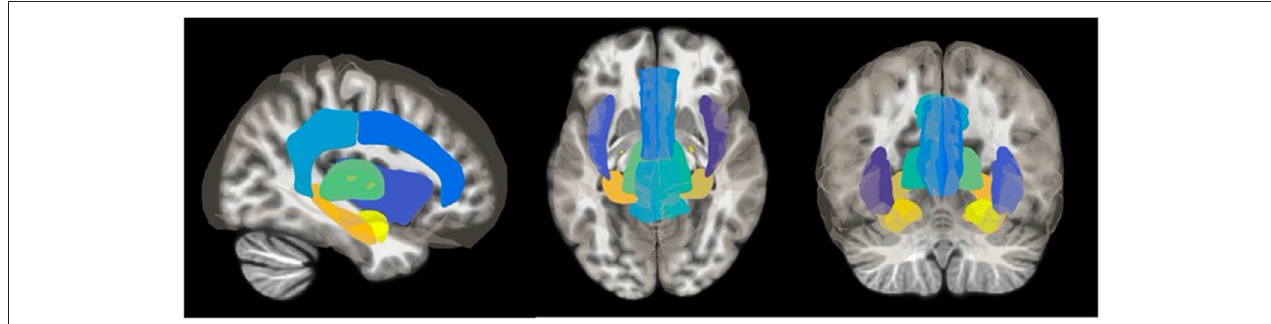
FIGURE 1 | Regions of interest (ROIs) used as seed points in fMRI analyses. Resting-state fMRI analysis was restricted to 10 ROIs composed of bilateral limbic and accessory sensory structures determined a priori : insula, thalamus, amygdala, hippocampus, anterior cingulate cortex, and posterior cingulate cortex. ROIs were generated from the Harvard-Oxford Atlas (28).